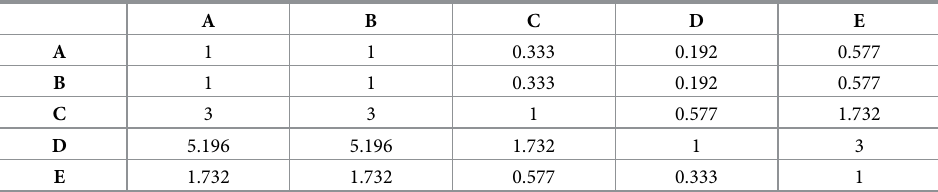
Table 5. Non fuzzy judgment matrix of each factor.